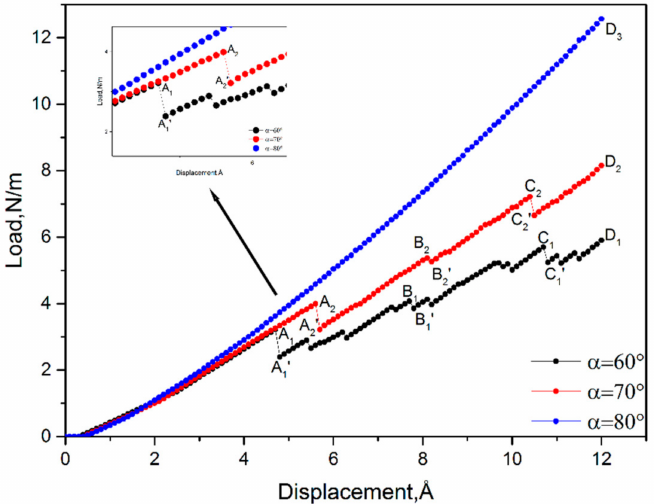
Figure 2. Load-displacement responses for wedged nanoindentation on Al single crystal by using indenters with different vertex